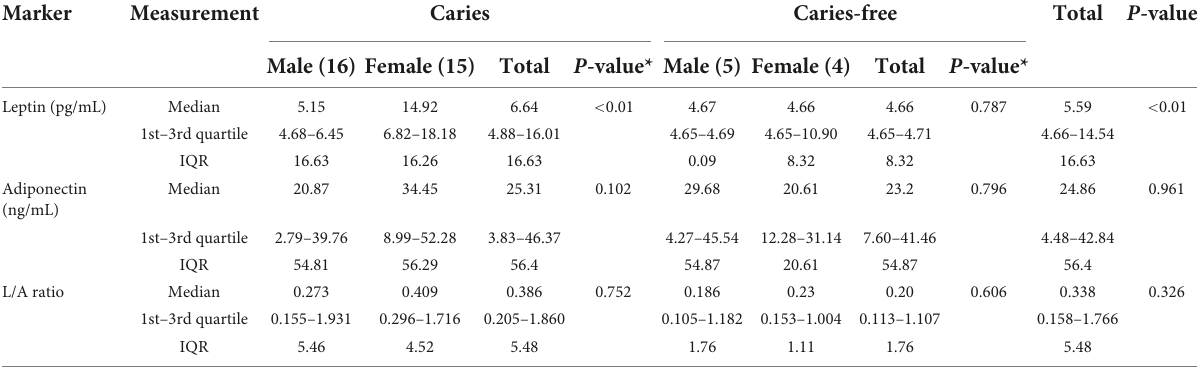
TABLE 2 Concentration of leptin and adiponectin in saliva supernatants of children with or without caries. Marker Measurement Caries Caries-free Total P -value*